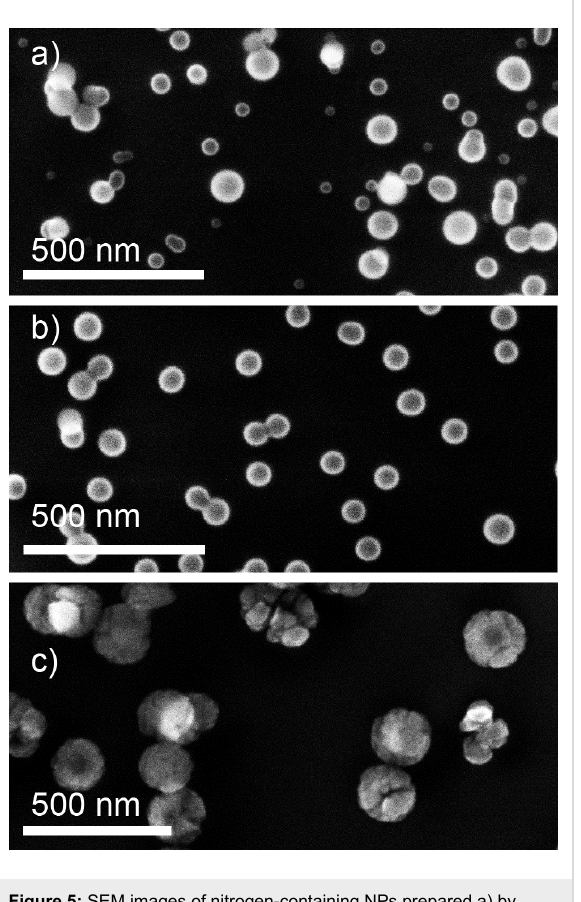
Figure 5: SEM images of nitrogen-containing NPs prepared a) by plasma polymerization of n -hexane in its mixture with Ar (total pres- sure 88 Pa, discharge power 40 W, C 6 H 14 flow 1.2 sccm, Ar flow 12.2 sccm); b) by plasma polymerization of n -hexane in its mixture with